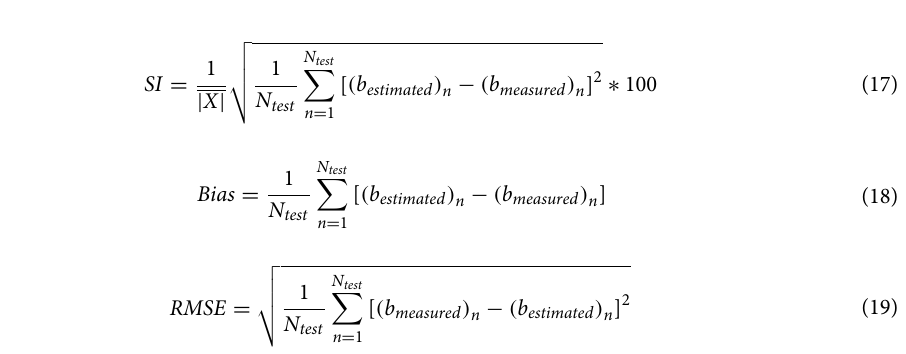
Figure 7. Influence of relative local water depth on Weibull b parameters: (a) impulsive wave conditions and (b) non-impulsive wave